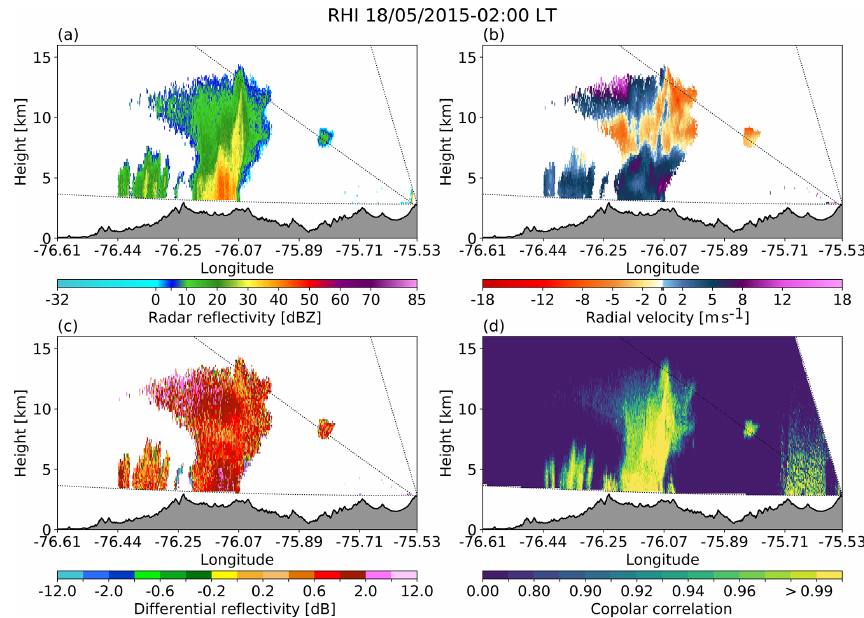
Figure 14. Vertical cross sections across the east–west direction (270 ◦ ) of the reflectivity field shown in Fig. 1, showing (a) horizontal reflectivity, (b) radial velocity, (c) differential reflectivity, and (d) polarimetric correlation coefficient. Notice the maximum altitude of the reflectivity field is about 15km and the base of the scans is about